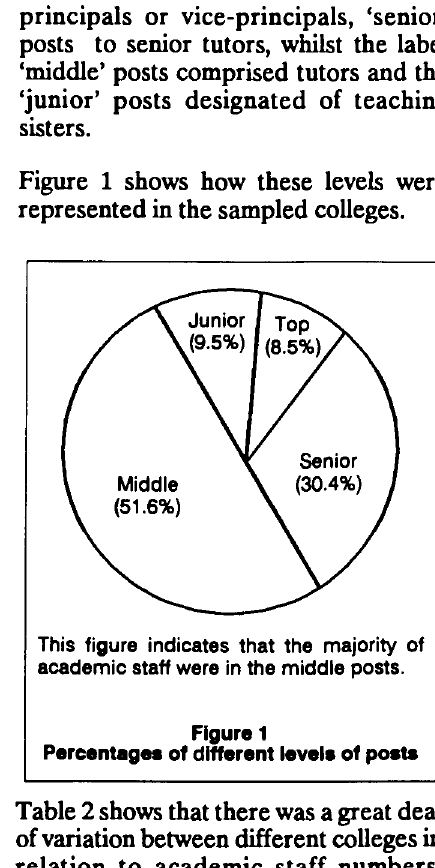
Figure 1 PercentagM of different level* of